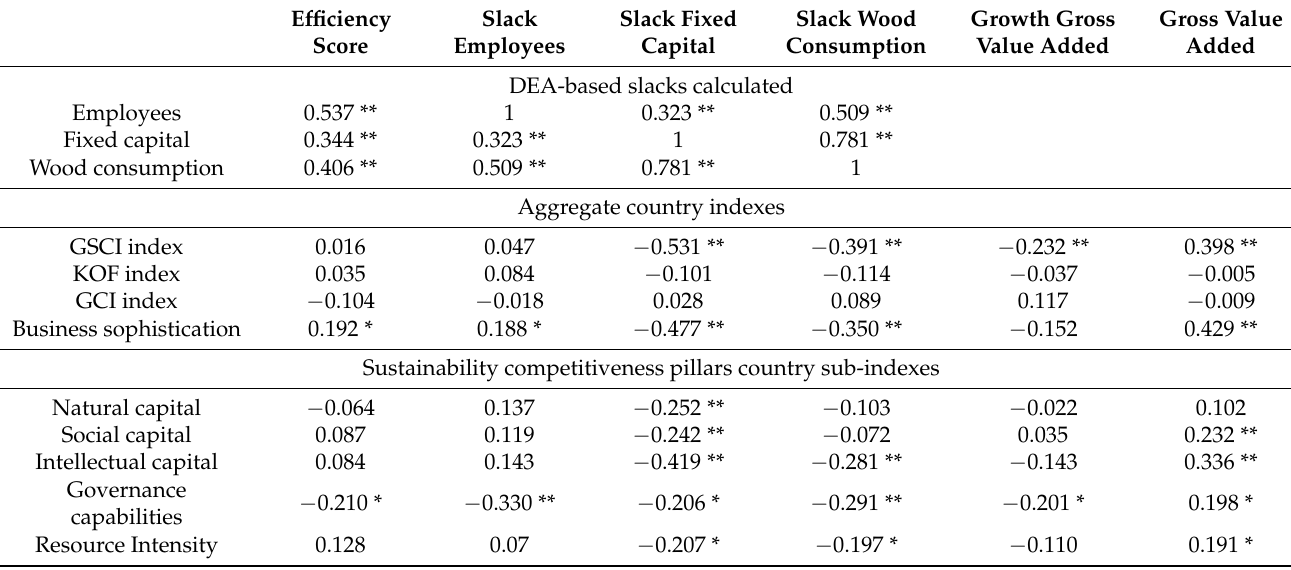
Table 3. Pearson correlation